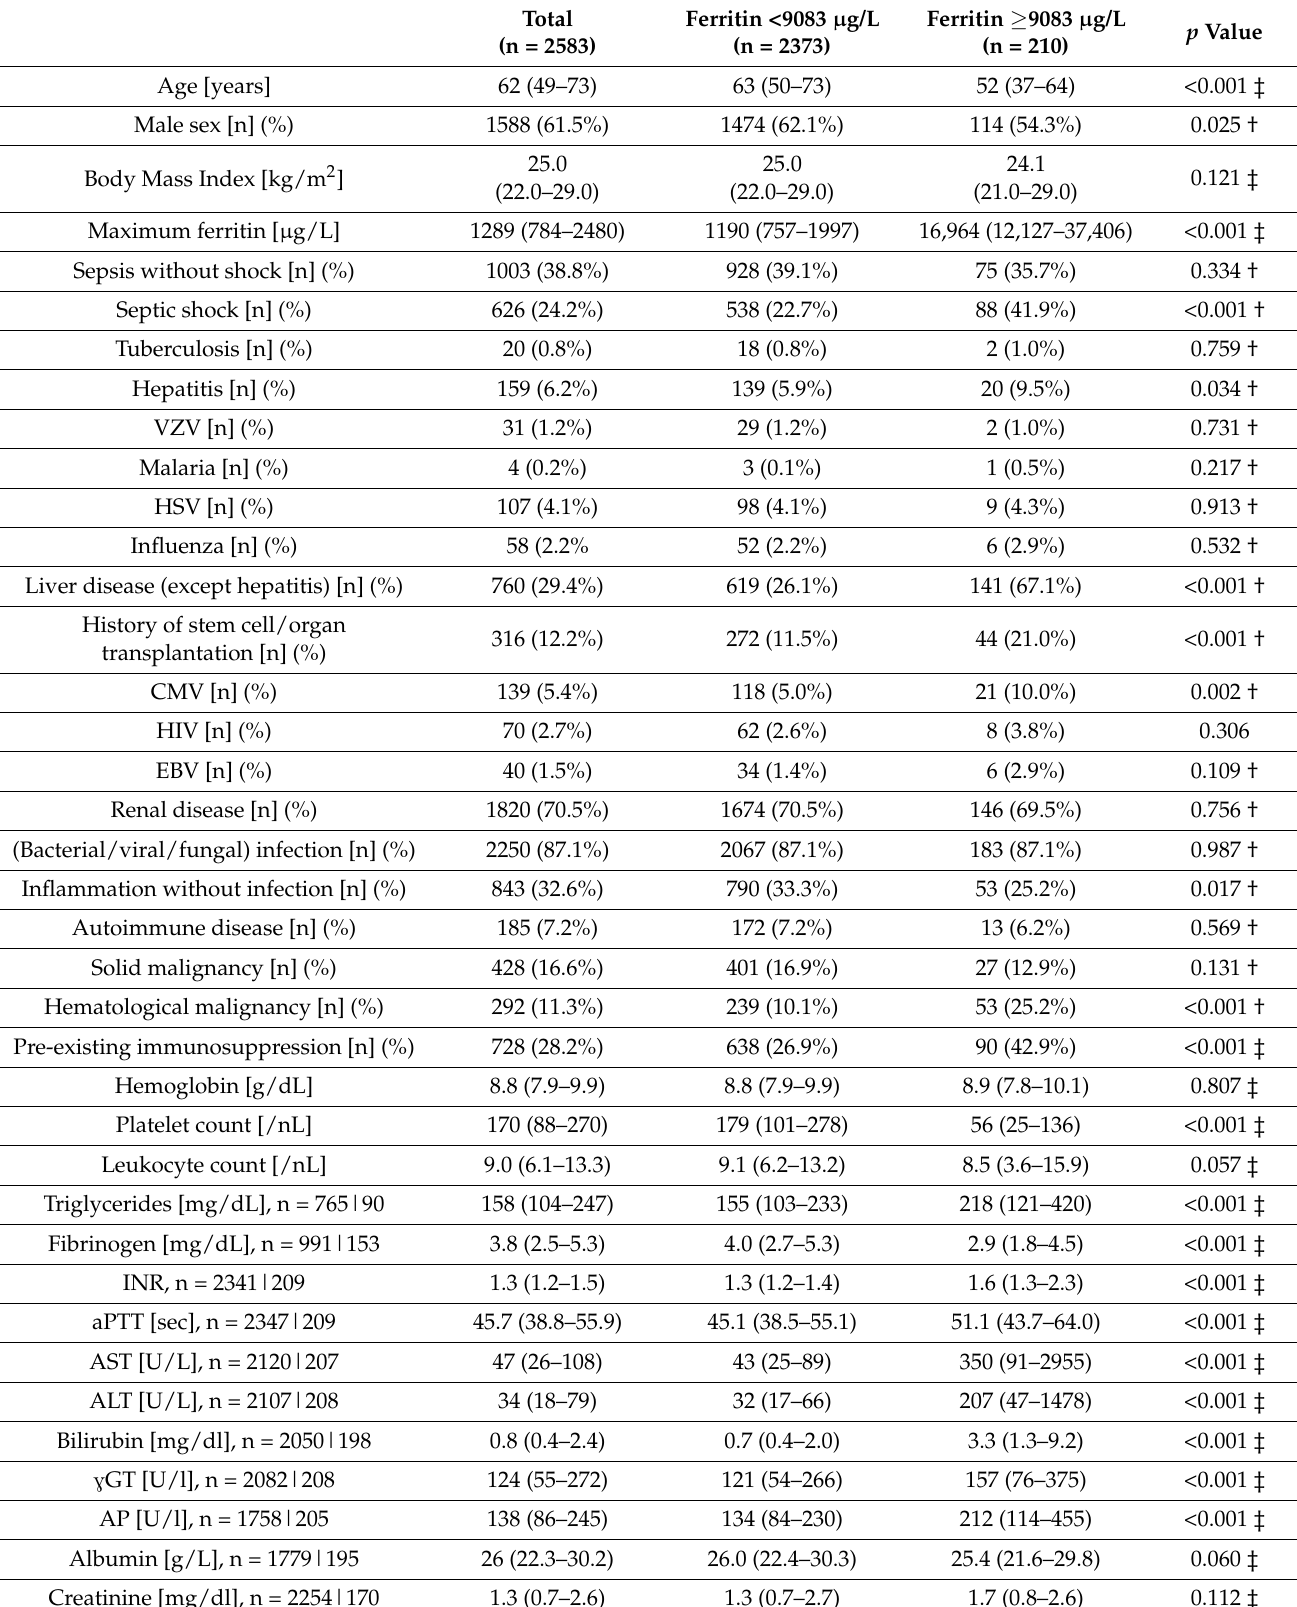
Table 1. Patient characteristics, diagnostic markers and outcome